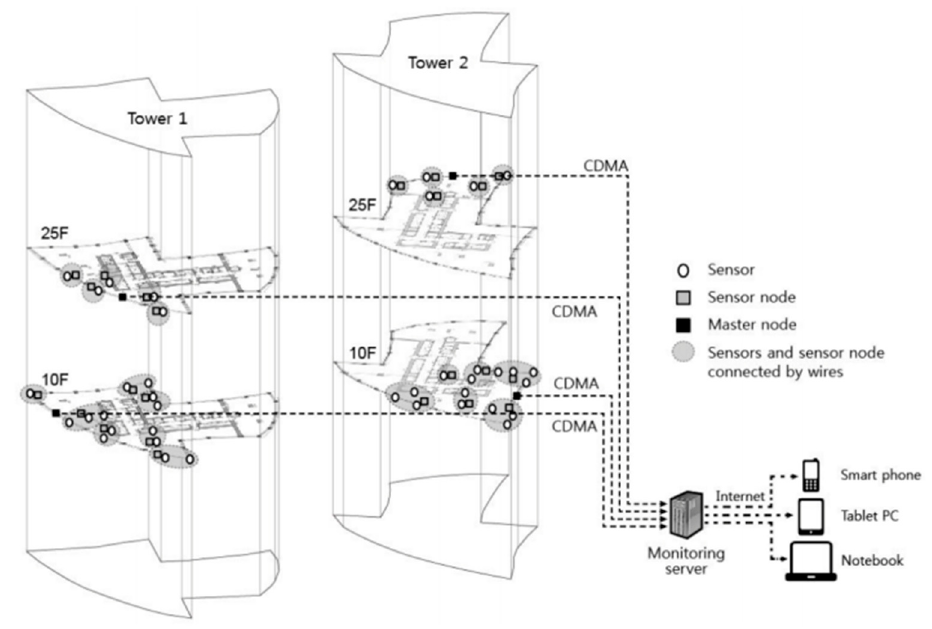
Figure 9. Location of sensor nodes and master nodes for field measurement of column shortenings in tower 1 and tower 2.